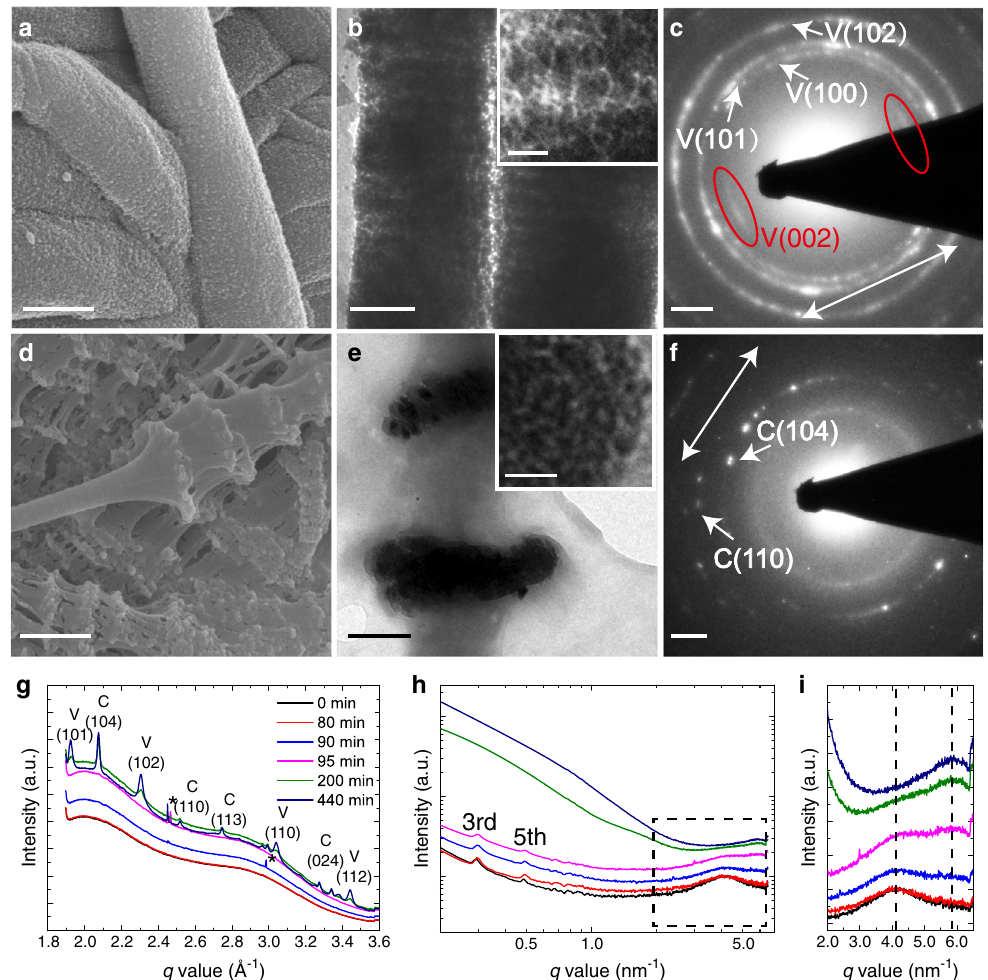
Fig. 5 Type I collagen fi bril mineralized with CaCO 3 in the presence of pAH. a , b SEM and TEM images of collagen fi brils mineralized by vaterite after 48 h, respectively. Inset: higher magni fi cation image showing the elongated morphology of the vaterite particles. c LDSAED of b showing arcs of vaterite (002) diffraction along the collagen fi bril axis. d , e SEM and TEM images of collagen fi brils mineralized by calcite after 48 h, respectively. Zoom-in image in the inset of e shows the nanoparticle subunits. f LDSAED pattern of e . The direction of the collagen fi bril long axes are highlighted by white arrows in c and f . g , h In situ WAXS and SAXS spectra of collagen fi brils during mineralization, respectively. * In g indicate the background signals from the X-ray or the mica windows. The 3rd and 5th order peaks corresponding to the 67 nm axial organization of collagen are highlighted in h . After long mineralization times, the signal from the CaCO 3 dominates, obscuring the signals of collagen. i Zoom-in of the square in h . The two vertical dash lines indicate the SAXS peaks related to the original lateral intermolecular distance of d = 2 π /4.08 nm − 1 (~1.5 nm) and the compressed d = 2 π /5.68 nm − 1 (~1.1 nm). Scale bars: a , d 500 nm, b , e 200 nm, Inset of b , e : 20 nm c , f : 1 nm − 1